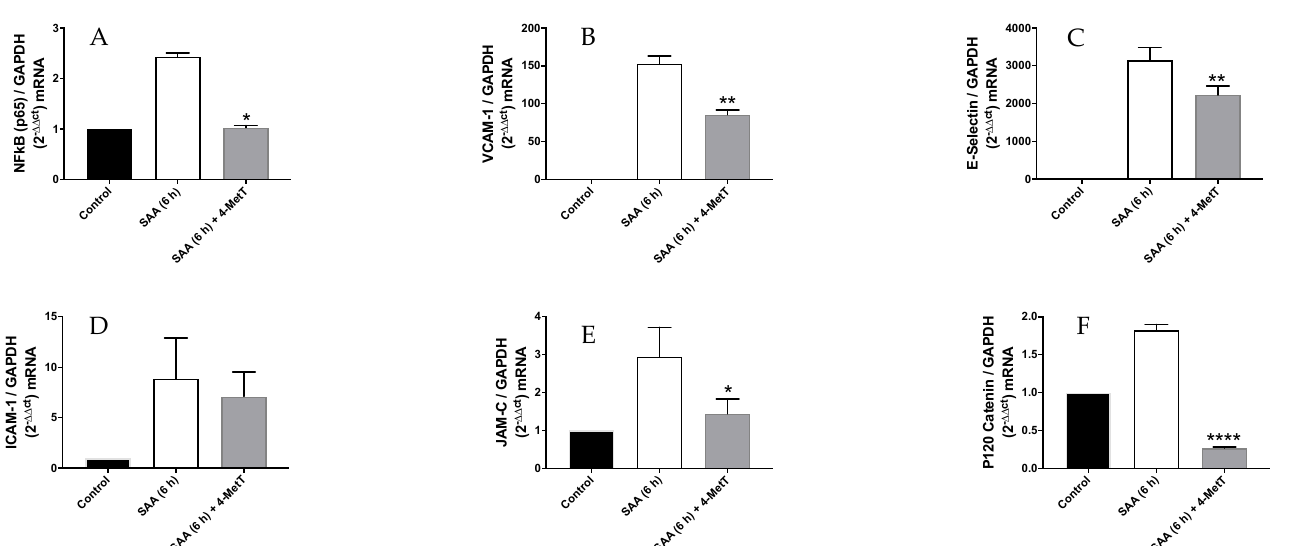
Figure 3. The effect of SAA and 4-MetT on pro-inflammatory, and adhesion molecule mRNA levels in cultured primary HAEC. Gene expression levels are shown for ( A ). NF- κ B, ( B ). VCAM-1, ( C ). ICAM-1, ( D ). E-Selectin. ( E ). JAM-C. ( F ). P120 Catenin. Gene expression across treatment groups was normalised against GAPDH and expressed relative to the control using the semi-quantitative 2 − ∆∆ ct method of analysis. Data represent mean ± SD, n = 3 in independent experimnets except VCAM-1, ICAM-1(n-2). * p < 0.05; ** p < 0.001; **** p < 0.0001 Different to SAA-treatment group.